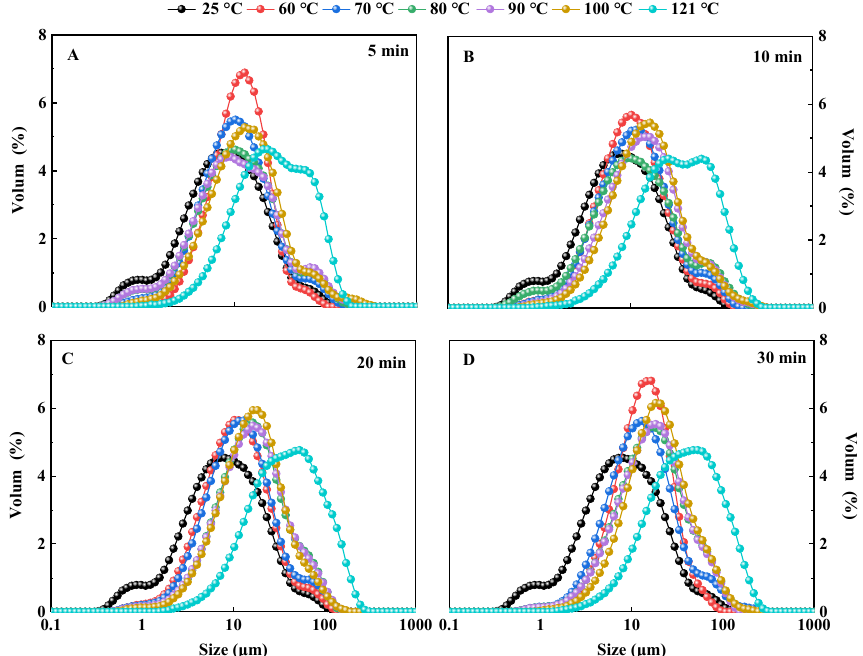
Figure 1. Effects of hydrothermal treatment of 5 min ( A ), 10 min ( B ), 20 min ( C ), 30 min ( D ) on particle size distribution of QPI.